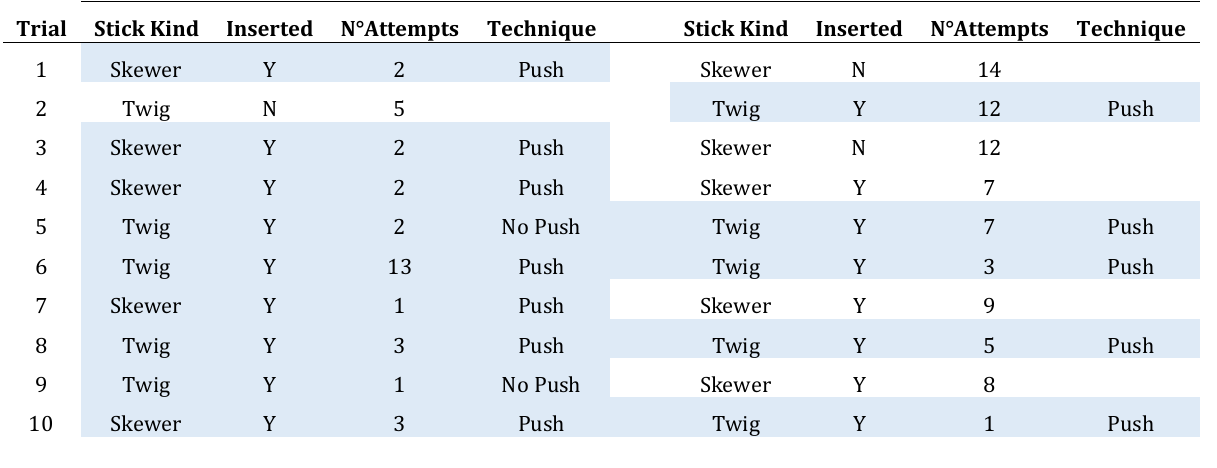
Table 3 Trial by Trial Description of the Behavior in Experiment 3